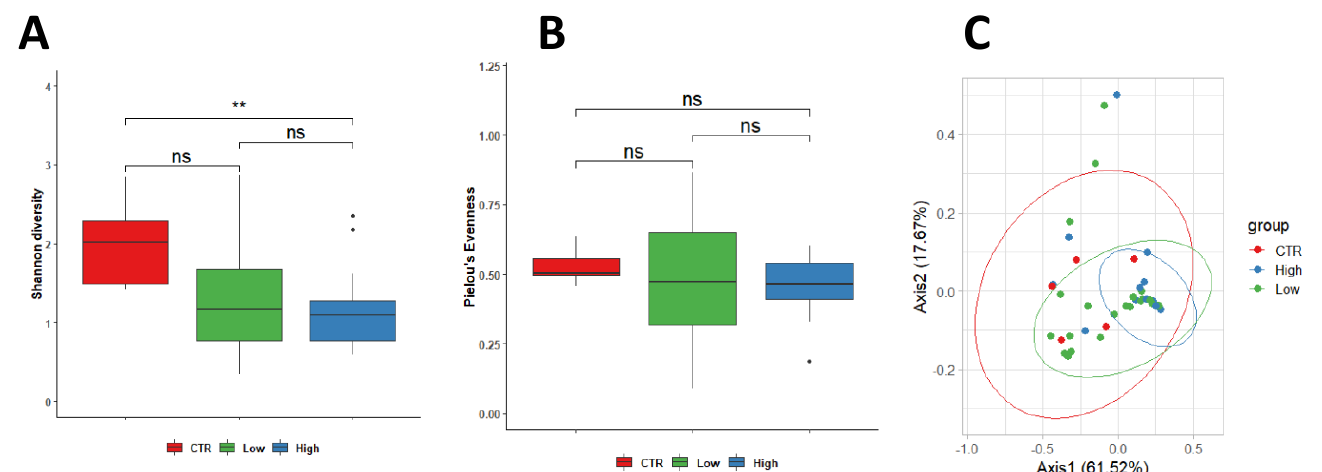
Figure 1. PERMANOVA statistical test showed a significant change between control and HLA- DQ2/DQ8 positive-RPL women in ( p = 0.037, R 2 = 0.109) in endometrial samples (Shannon diversity). No significant differences were observed between RPL women independent of the HLA-DQ2/DQ8 state ( p = 0.900) ( A , B ). Differences in the microbial population between healthy control and women with CD predisposition were assessed using weighted Unifrac beta diversity. The obtained distance matrix was represented as PCoA, showing a clusterization among the three studied groups ( C ). Legend: CTR = control; Low = HLA-DQ2/DQ8 negative-RPL women; High = HLA-DQ2/DQ8 positive-RPL women. ** significantly different.